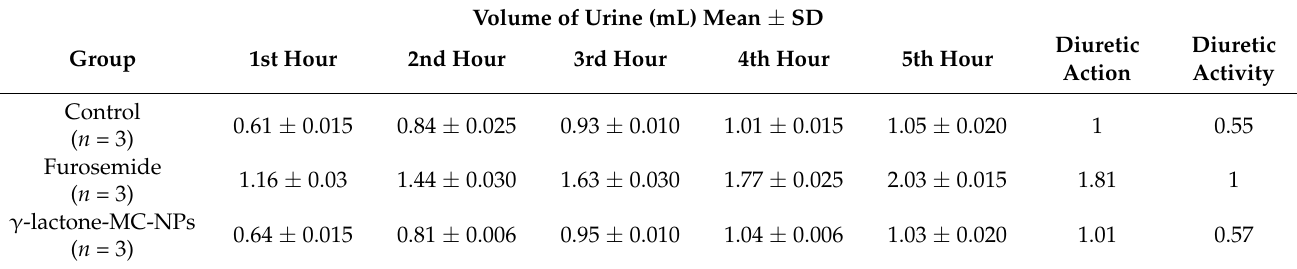
Table 4. The diuretic effect of oral γ -lactone-MC-NPs in rats. Volume of Urine (mL) Mean ±